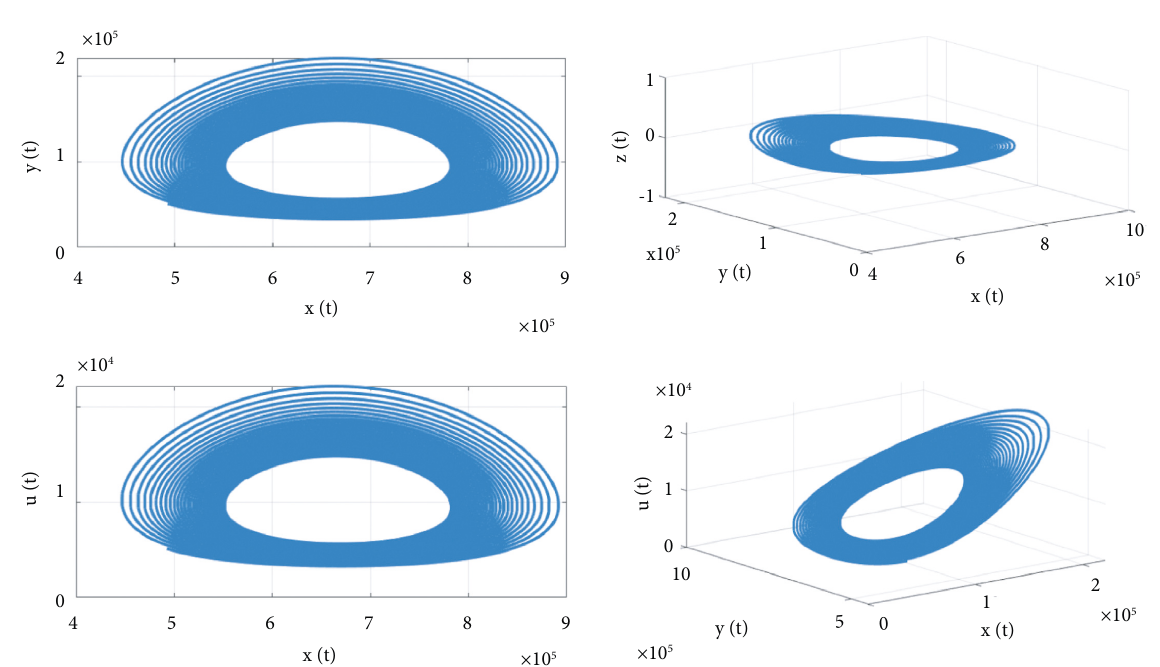
Figure 1: Unstable responses for the time delay τ > 0 .